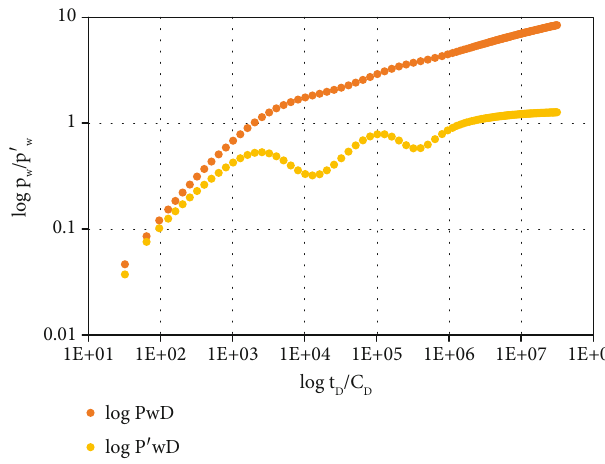
Figure 3: Theoretical double logarithm characteristic curve of dual-media composite reservoir model. Table 1: basic parameter table. Formation parameters